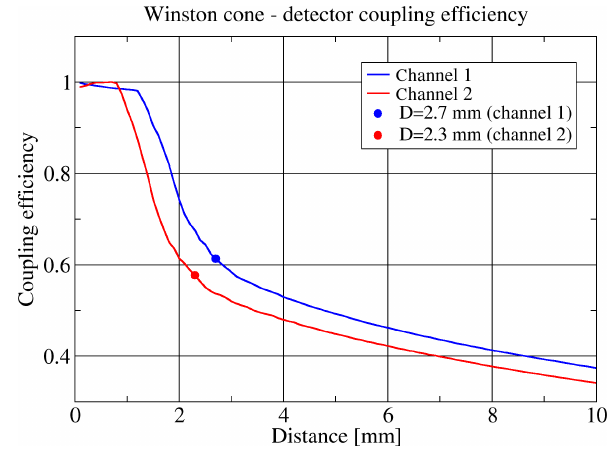
Figure 3. Plot of the concentrator–detector coupling efficiency as a function of their distance for both channels. The solid dots show the actual operating point, corresponding to a concentrator–detector distance of 2.7mm for channel 1 and 2.3mm for channel